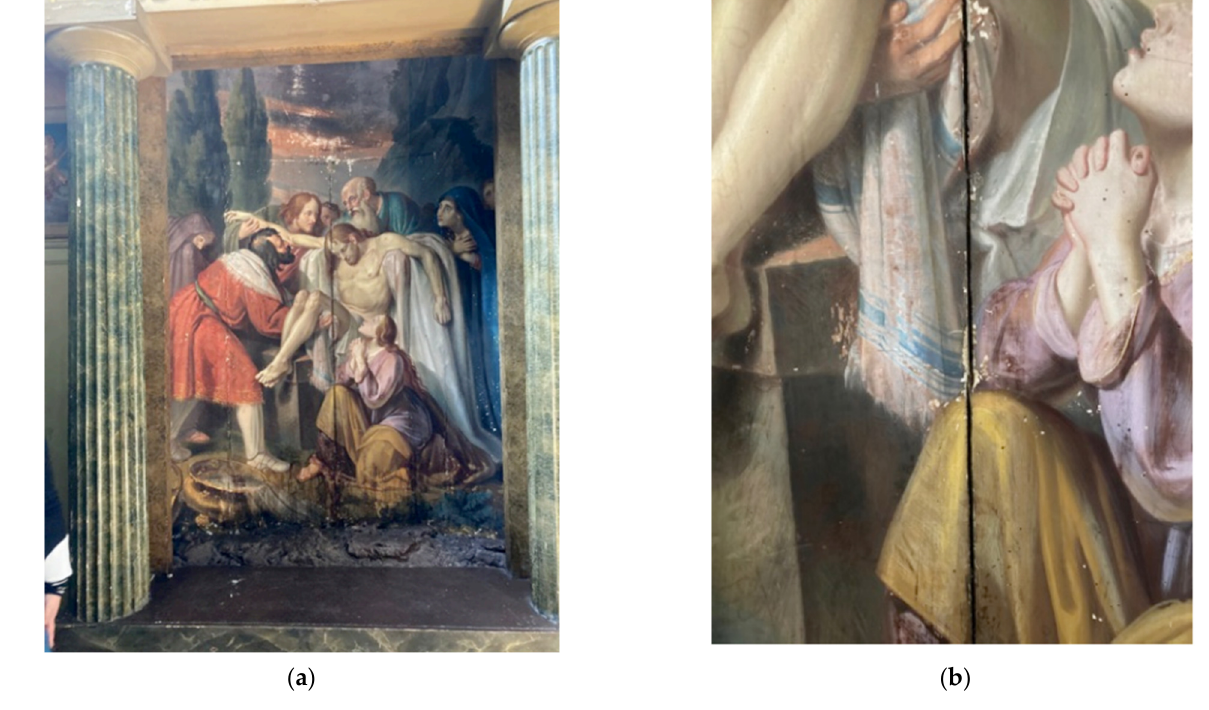
Figure 9. Microclimate monitoring system installed in the real painting ( a ) and a zoom ( b ) where the measurement system is installed inside the inlet.